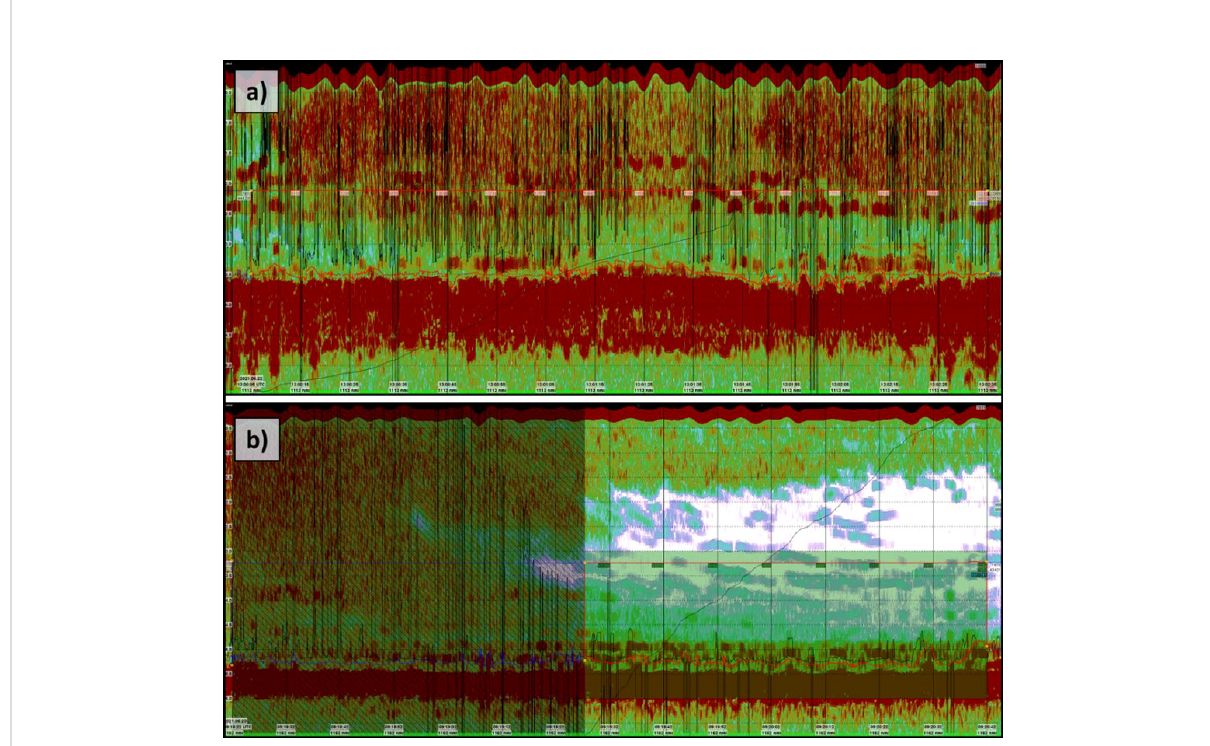
FIGURE 9 (A) Echogram from Helgeland station 132, one of the stations that has been excluded from the dataset. The shallow depth to the seabed and the large amount of air bubbles from the propeller makes it impossible to determine kelp canopy height. The average backscatter strength of the echogram is also remarkably high due to the bubble attenuation. (B) Echogram from Helgeland station 21 where the fi rst half of the recordings are signi fi cantly in fl uenced by the presence of air bubbles in the water column. Only the second half of the pings were used for calculating backscatter